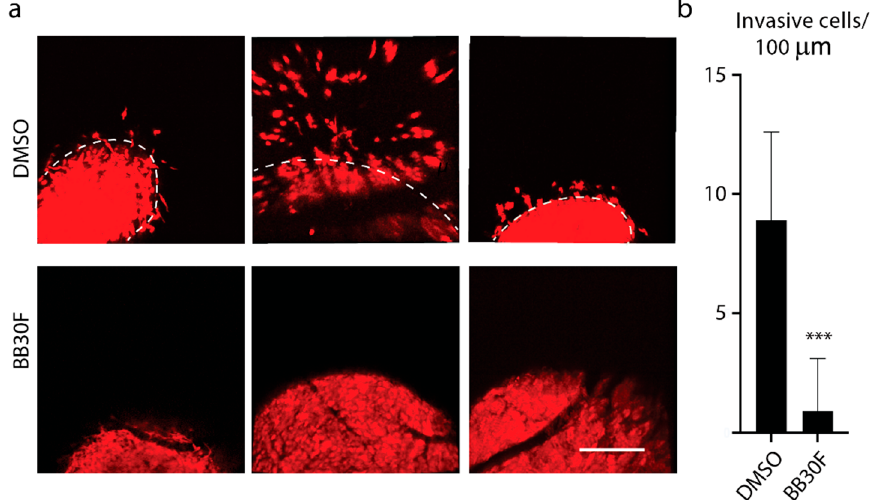
Figure 7. Intravascular intravenous application of BB2-30F compound blocks to HT1080 human fibrosarcoma cancer cell invasion in vivo. ( a ) Representative images of invasive tumor fronts of DMSO-treated controls (upper row) and BB2-30F-treated HT1080 tumor fronts. ( b ) Quantification of invasive tumor cell numbers for conditions in ( a ). Dashed lines in ( b ) delineate the primary tumor borders. Scale bar = 100 µ m; *** indicates significant difference at p <